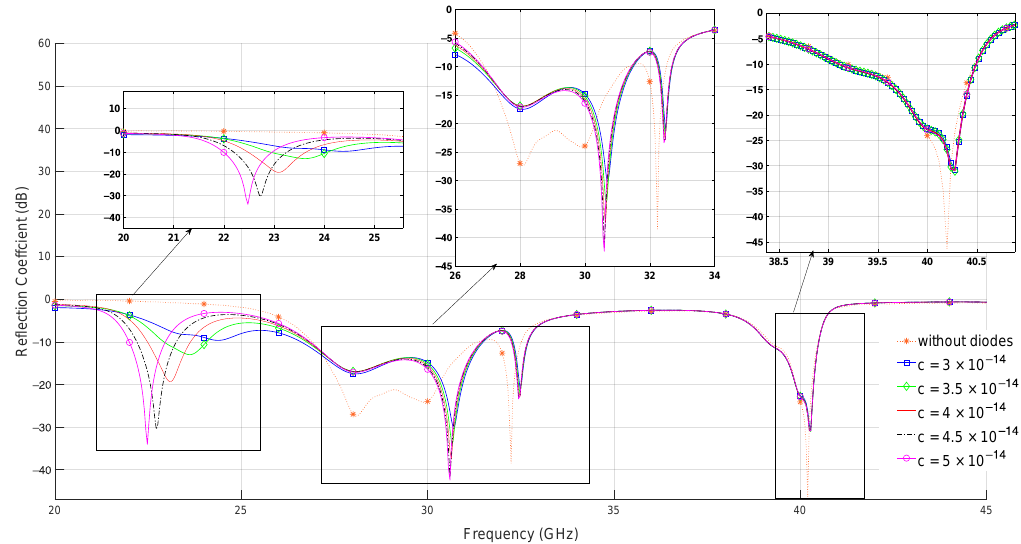
Figure 7. Return loss simulation results of 16 element metasurface array with and without PIN diodes.